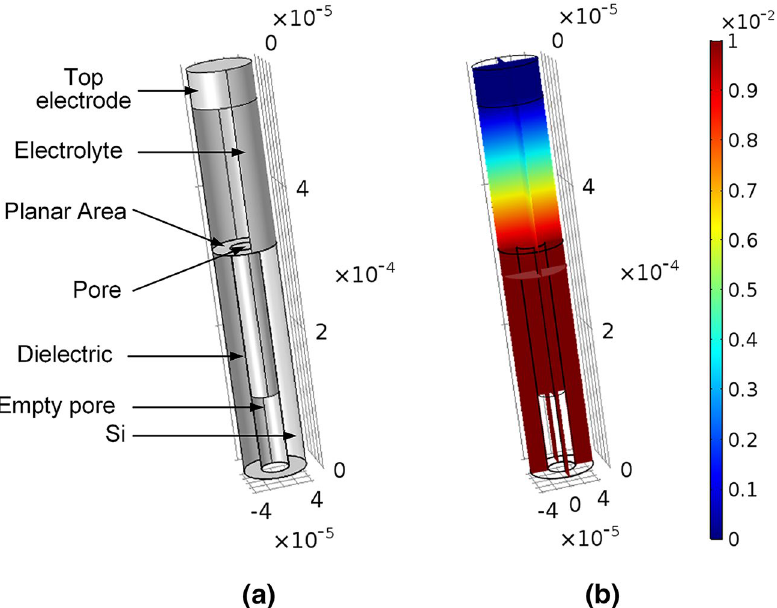
Figure 3. ( a ) 3D COMSOL model of a 38 µ m single pore, and ( b ) voltage distribution of the single pore.